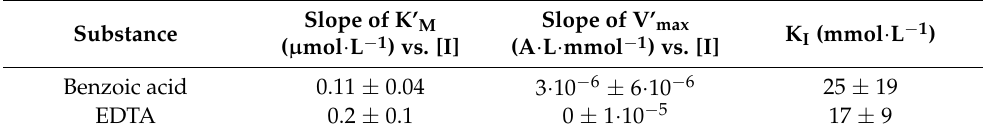
Figure 11. Biosensors kinetic study, ( A ) Lineweaver–Burk linearization for four EDTA concentrations; ( B ) representation of the obtained K’ M values for each inhibitor concentration; and ( C ) V’ max obtained values for each inhibitor concentration. Table 4. Variation of kinetic parameters vs. inhibitor concentration. Values of the linear trend K’ M and V’ max vs. Inhibitor concentration when kinetics of the laccase enzyme is evaluated. Inhibition values from calibration curves of catechol in different concentrations of acid benzoic and EDTA